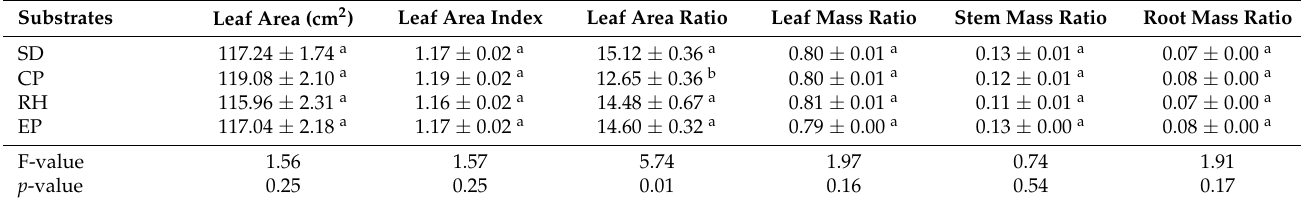
Table 2. Leaf, stem, and root growth features of lettuce in soilless